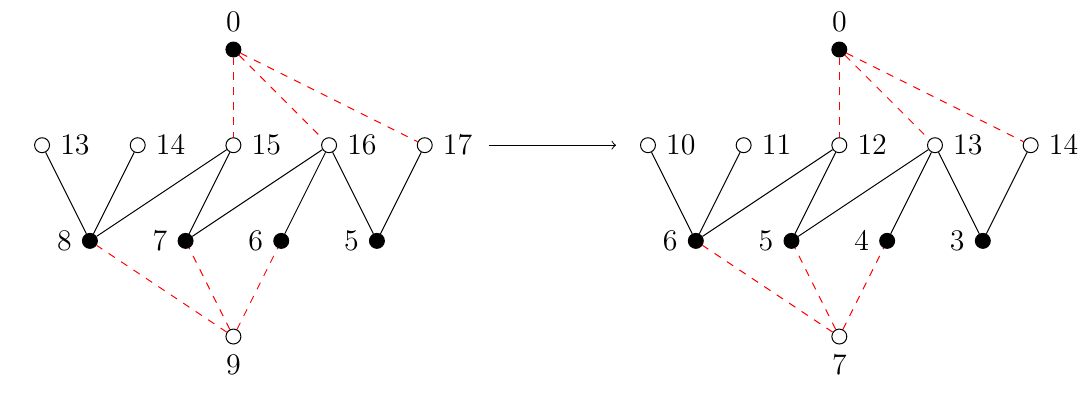
Figure 7: A way to obtain smaller α